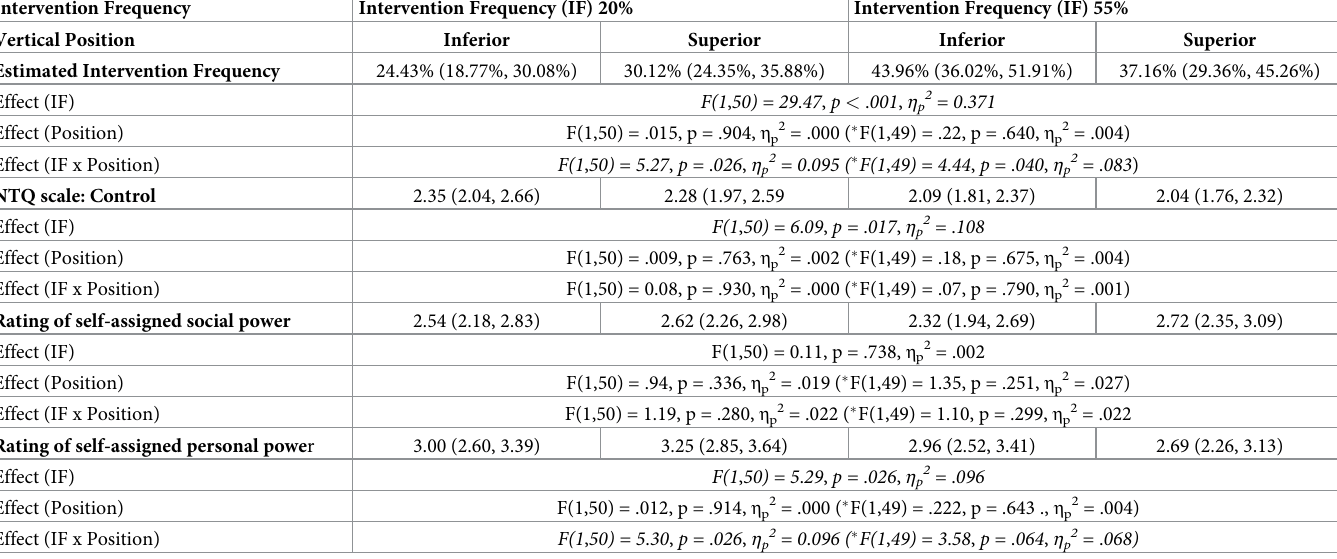
Table 1. Descriptive statistics and ANOVA results for questionnaire data, separated for intervention frequency (IF, 20% vs. 55%) and group assignment (vertical position: inferior vs. superior). To each mean value, upper and lower limits of confidence intervals (95%) are additionally provided. ANOVA results for the factor vertical position are additionally controlled for the covariate ’age of participant’ in an ANCOVA. All ANCOVA results are indexed by an asterisk ( � ). Intervention